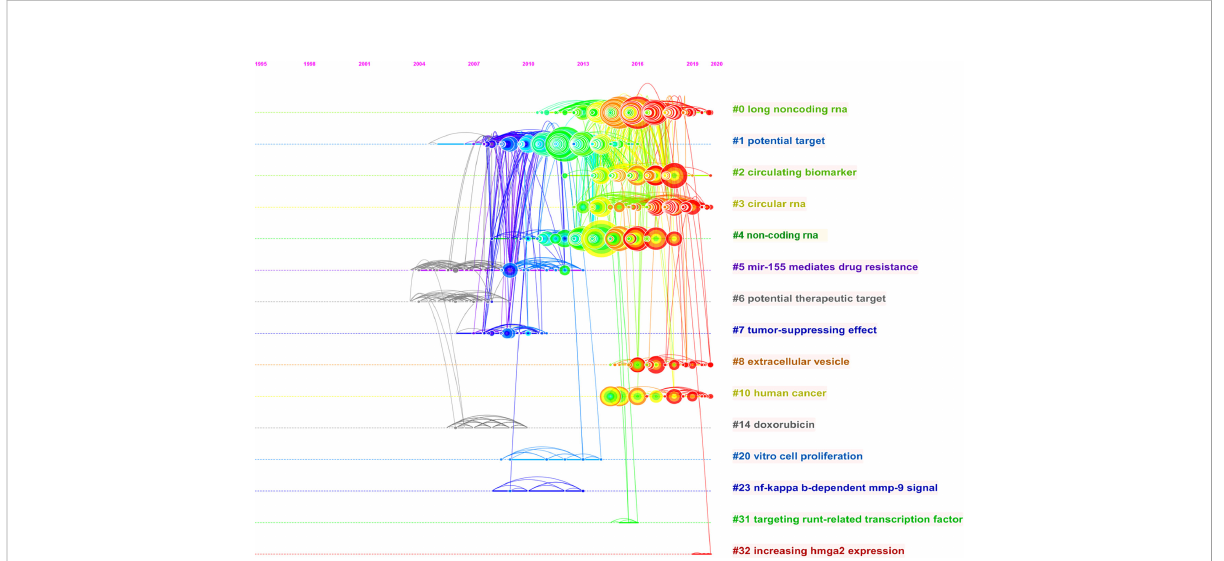
FIGURE 6 The timeline view map of reference co-citation analysis. For each cluster, the position of each node shows the time of publication of the document, and the node size represents the number of